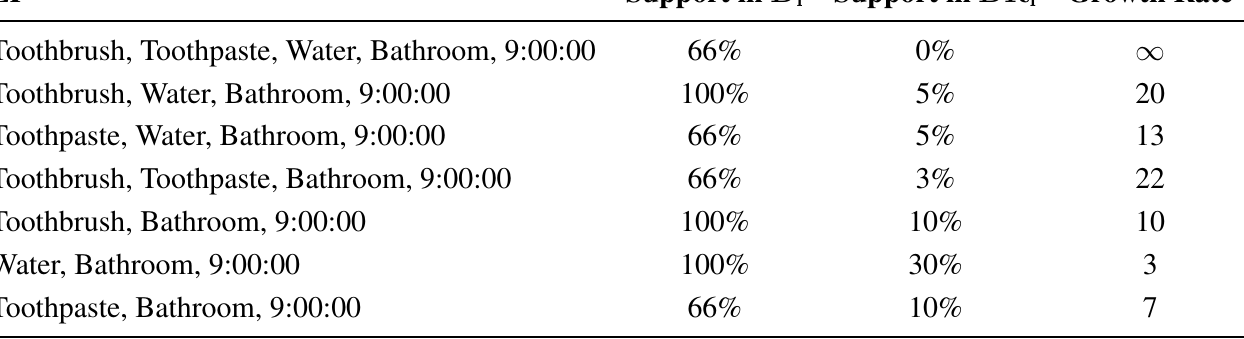
Table 3. Emerging Patterns extracted for the brushing teeth